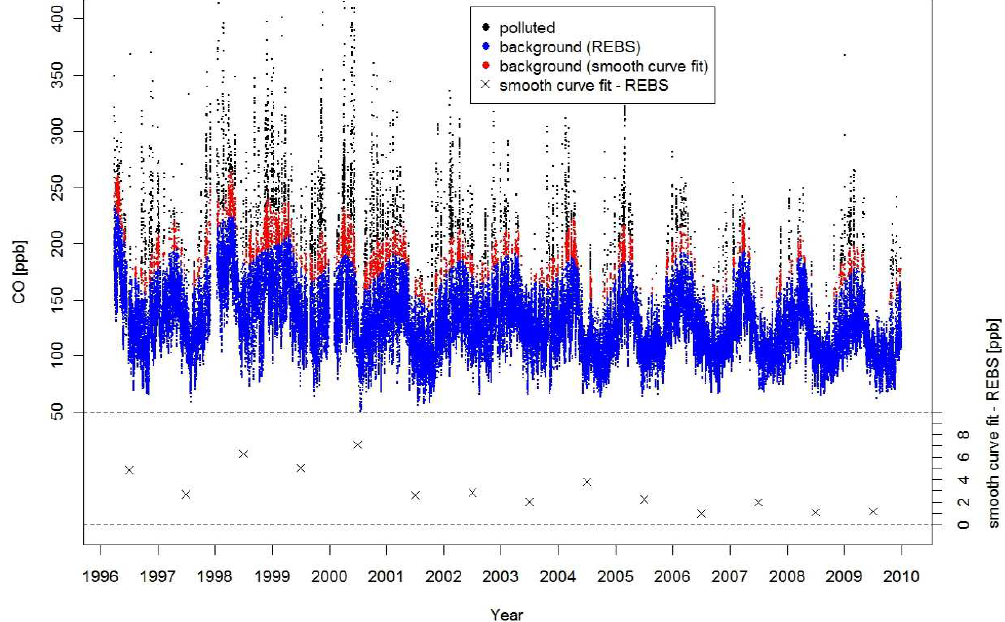
Fig. 2. Measured CO during impact of regionally polluted air masses (black points) and background CO concentrations at Jungfraujoch for the 1996–2009 period as identified by the REBS technique and the smooth curve fit. The black crosses indicate the difference of annual background concentrations obtained by the two data filtering